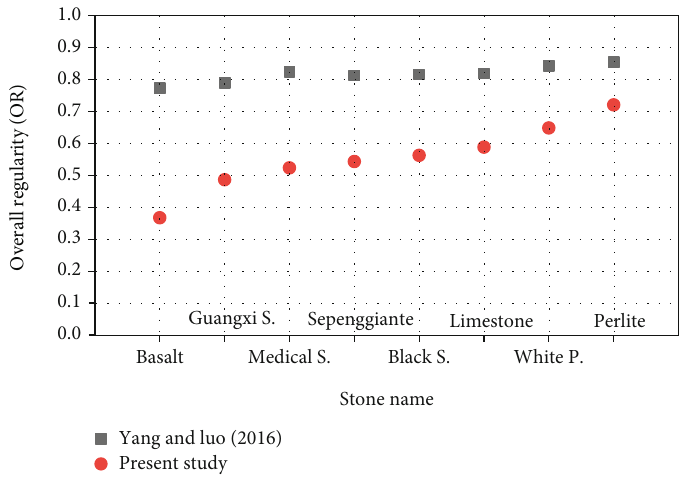
Figure 7: The results of the method of Yang and Luo [29] and the present study.